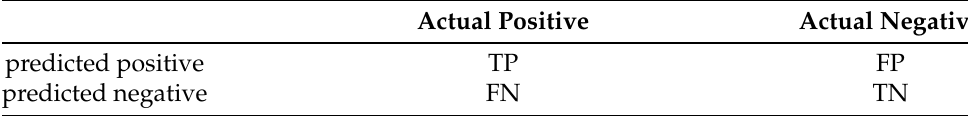
Table 3. Confusion matrix.